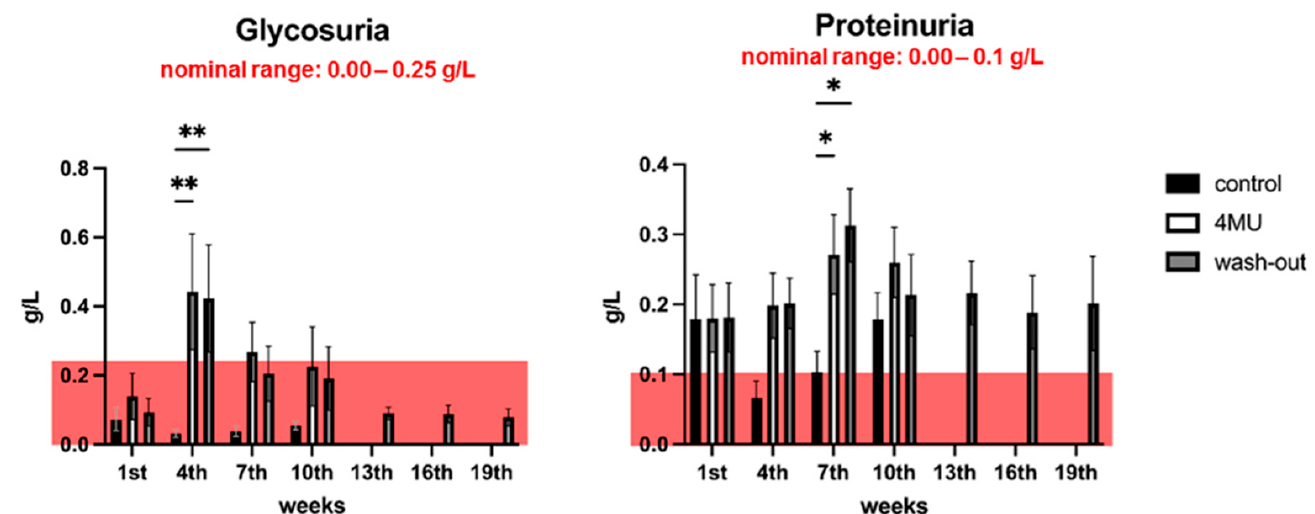
Figure 4. Glycosuria and proteinuria show no severe kidney damage after 1.2 g/kg/day of 4MU-treatment. The bar graph shows the level of urinary glucose changes ( A ) and urinary protein changes ( B ) during the 4MU treatment. The pink box in each graph indicates the nominal range of the correspond- ing test. Data are expressed as a mean ± SEM; * p < 0.05, ** p < 0.01 by two-way ANOVA with Tukey’s multiple comparisons test, n = 7.